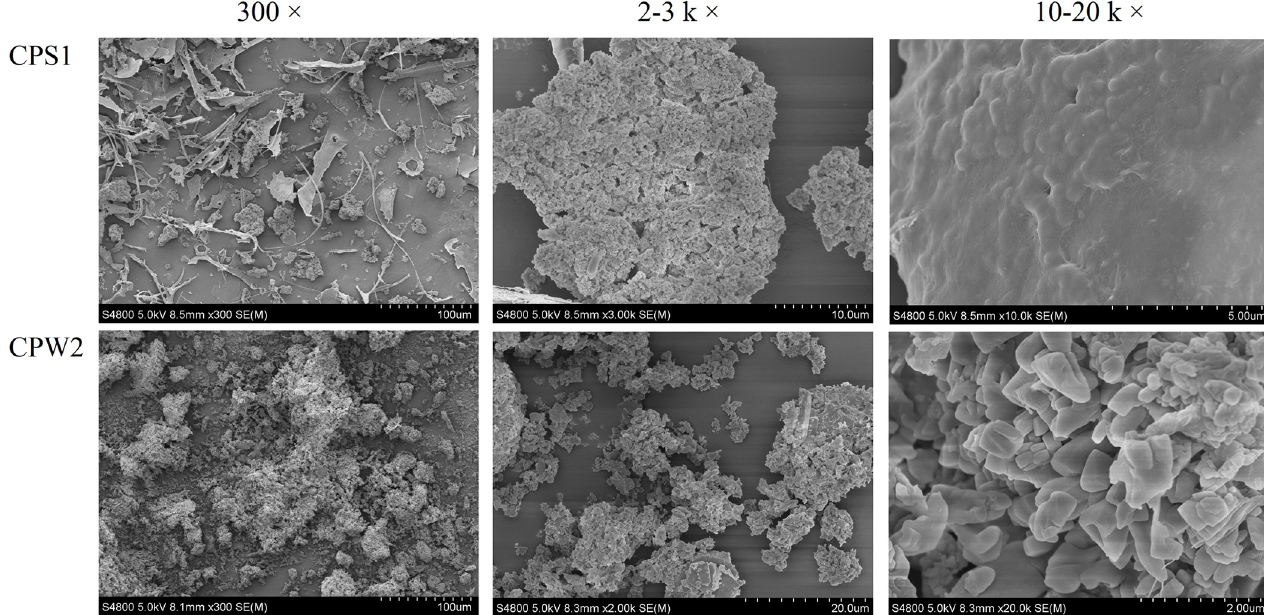
Fig 4. SEM images of CPS1 and CPW2 (300 × - 20 k × ).